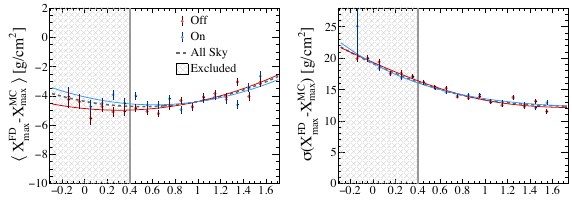
Figure 4: The X max reconstruction bias and resolution pa- rameterizations for the on- and o ↵ -plane sky regions from Monte Carlo. Note: only the detectors and reconstruction X max resolution is shown. Other e ↵ ects lowering the reso- lution are included as specified in [6].